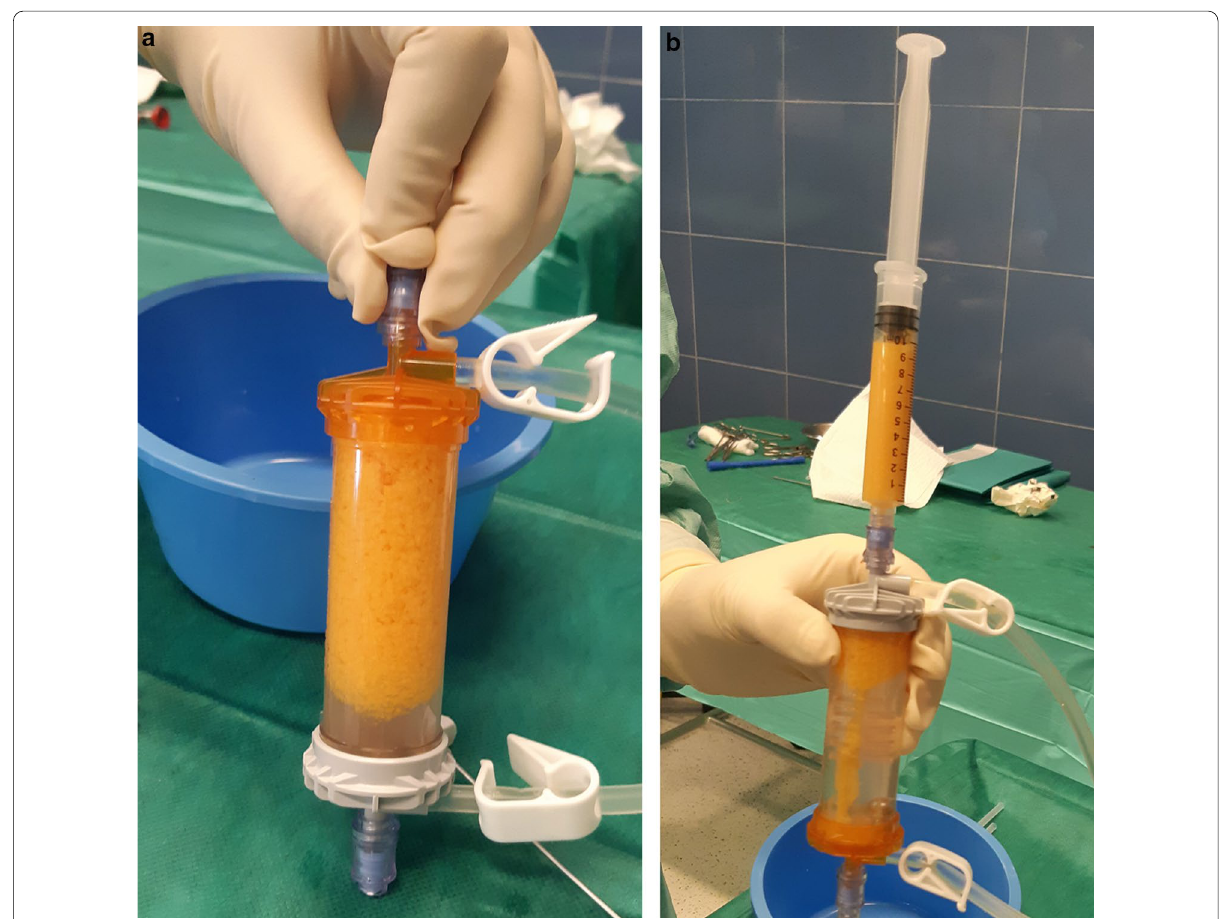
Fig. 4 The processed final microfragmented adipose tissue product ( a ) is transferred to 10 ml syringes ( b ) for the successive intraarticular